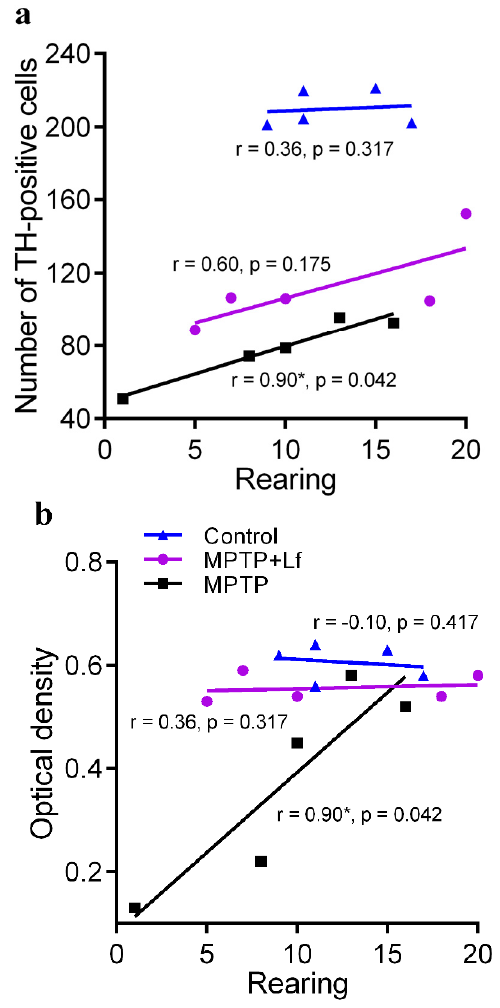
Figure 7. Relationship between the number of rearings in open field and the number of TH-positive neurons ( a ) and the optical density of TH-positive fibers ( b ) of the MPTP/saline-treated mice on day 28. * significant correlation (Spearman’s rank